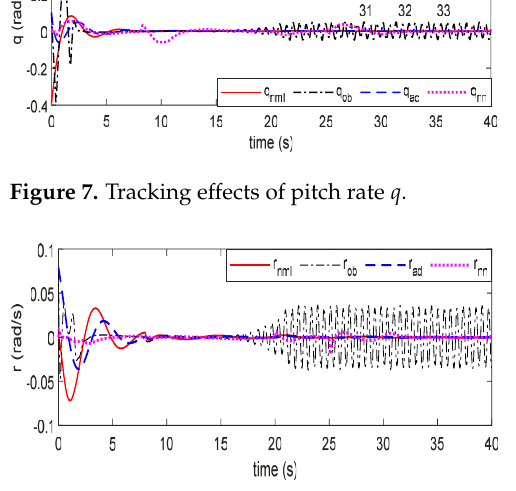
Figure 8. Tracking effects of yaw rate r